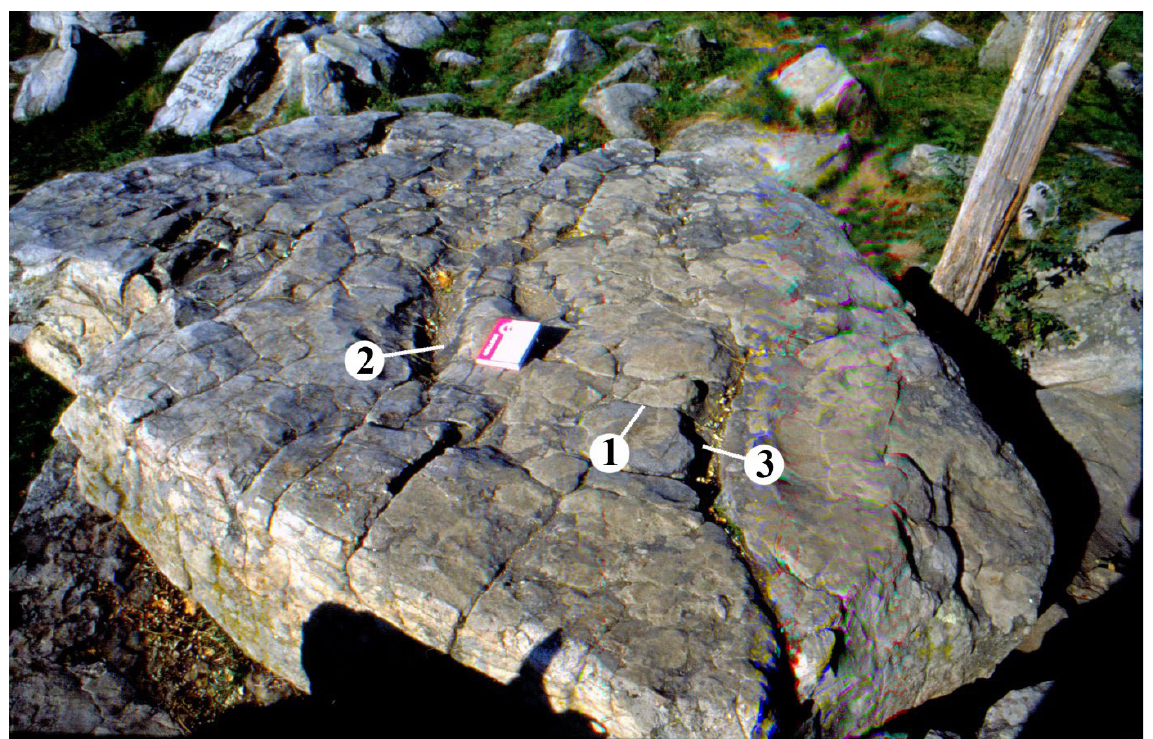
Figure 10. Karren near Szentbékkálla. Legend: 1. sandstone polygon, 2. kamenitza, 3. rinnenkarren. Pseudokarst caves are most widespread on basaltic terrains. From the ascending